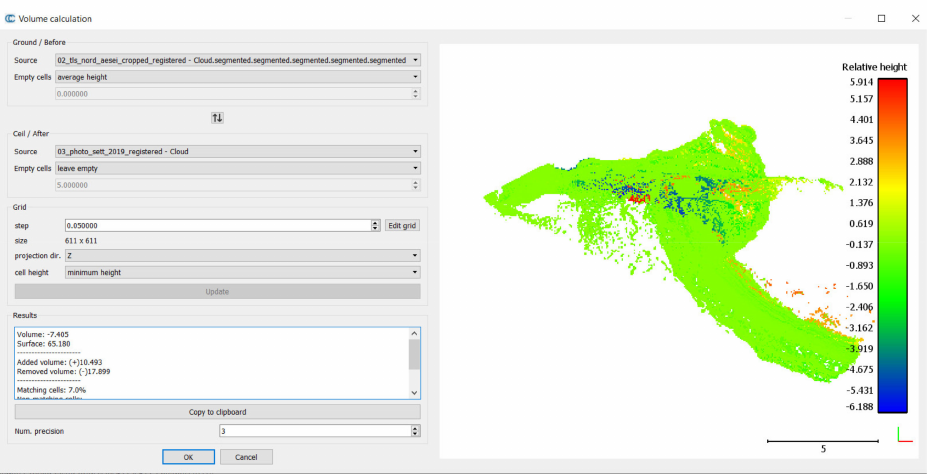
Figure 24. Calculation of the 2D volumes in Cloud